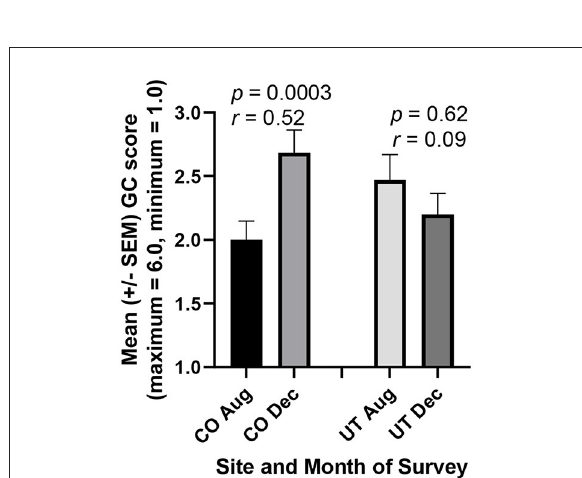
FIGURE4 Prospective medical students General Confidence (GC)